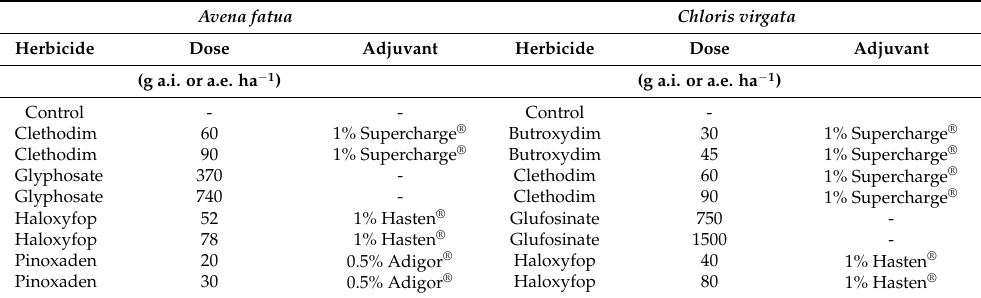
Table 1. Herbicide (systemic) treatments, herbicide doses, and adjuvants used with herbicides in the grazing experiments conducted with Avena fatua and Chloris virgata . Avena fatua Chloris virgata Herbicide Dose Adjuvant Herbicide Dose